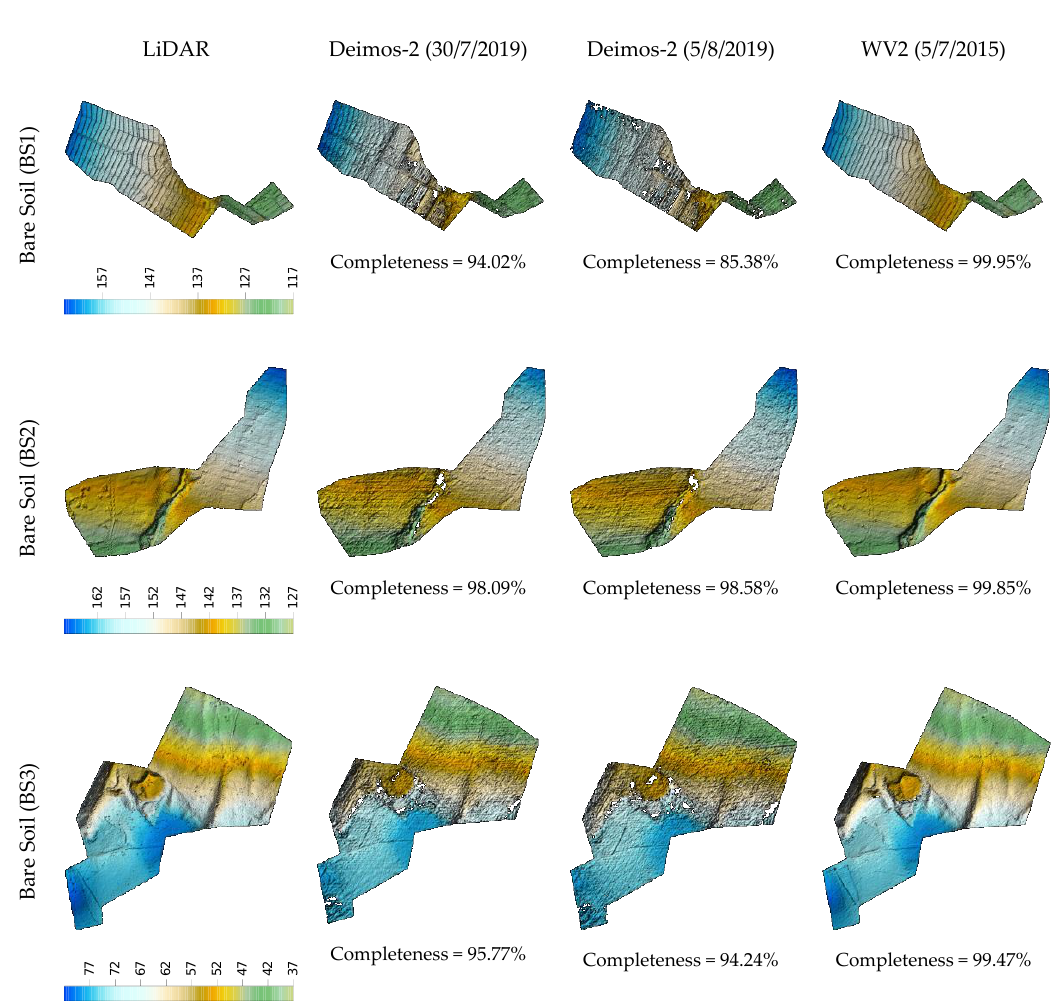
Figure 5. DSMs and completeness values corresponding to the three subareas of bare soil land cover (BS1, BS2 and BS3) generated from the first and second Deimos-2 stereo pairs (second and third column) and the WV2 stereo pair (fourth column). The reference LiDAR is depicted in the first column.